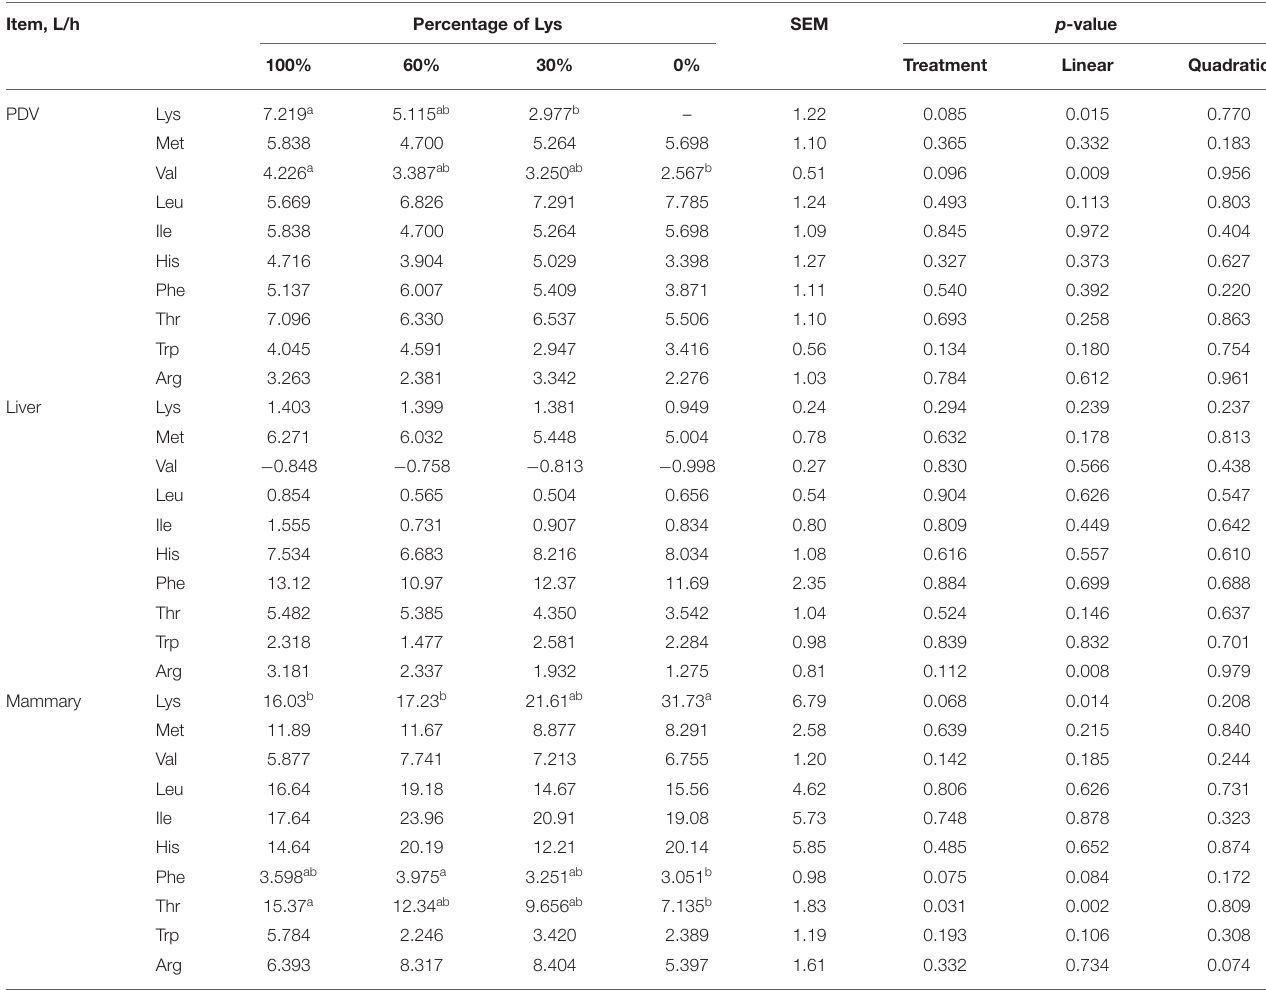
TABLE 8 | Effects of graded removal of Lys from the AA mixture infused into abomasum on PDV, liver and mammary amino acids clearance rates of lactating goats. Item,